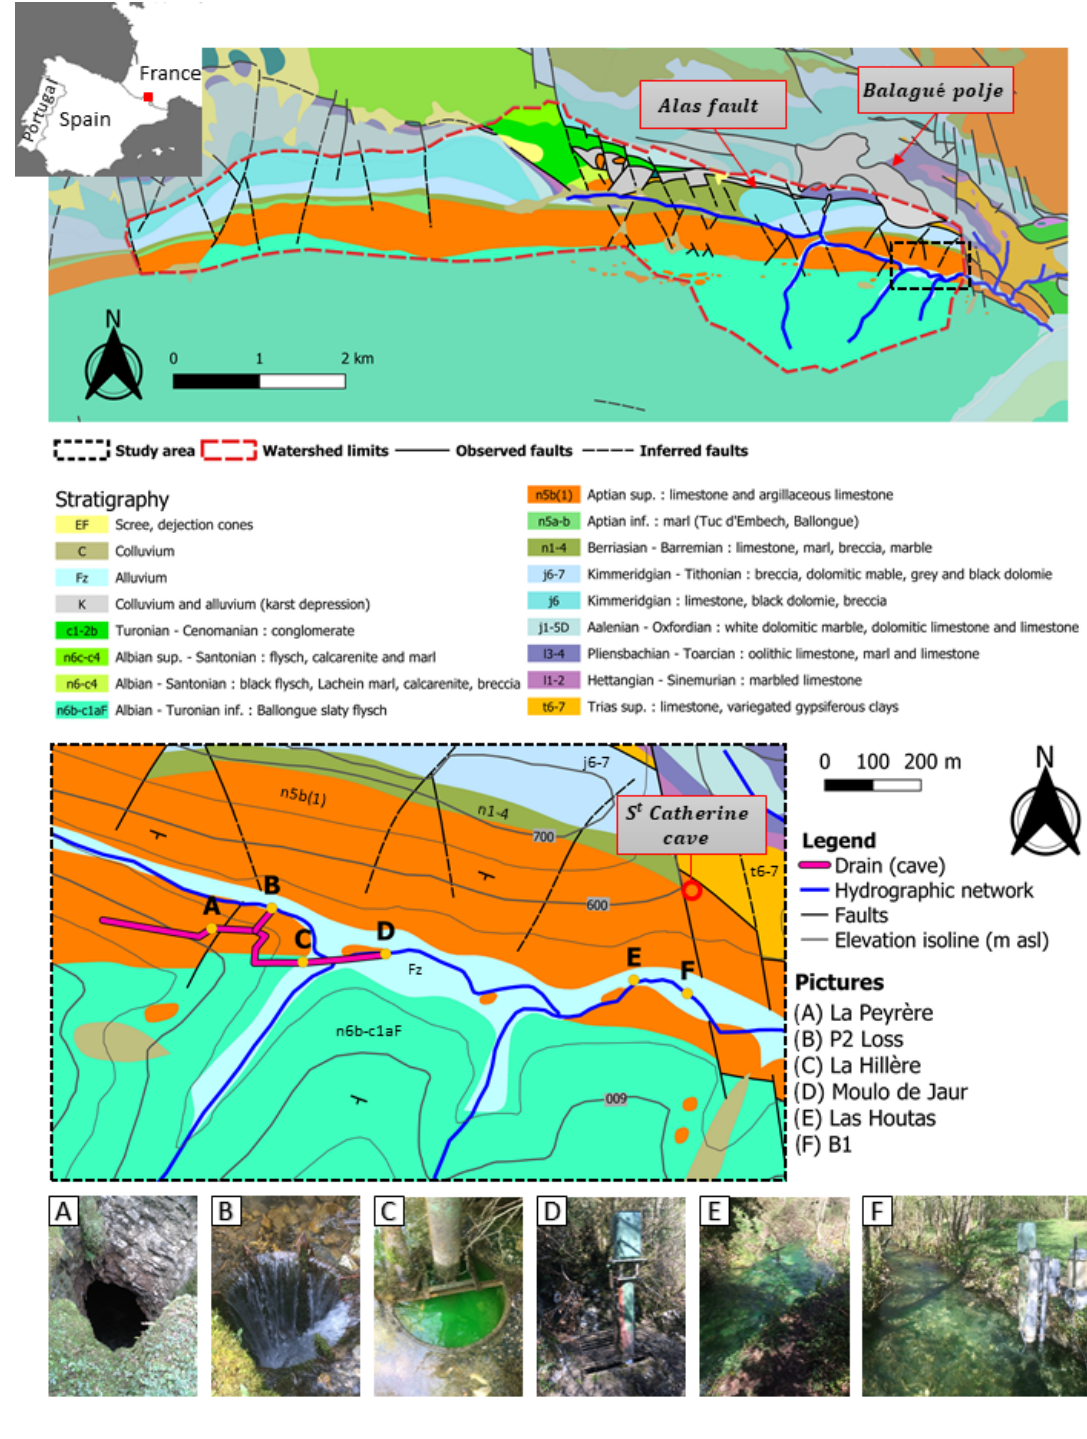
Figure 1. Location of the Baget karstic system, a geological map of the area (modified from [54]) and limits of the watershed (red dashed line). The study area concerns the downstream part of the watershed (black dashed line), in the mid mountains Lachein valley, characterized by altitude from 450 m a.s.l. to 750 m a.s.l. [55]. The pictures show remarkable features across the area: ( A ) La Peyrère is a cave connected to the main drainage system, ( B ) P2 Loss is the point of injection for artificial tracer tests, ( C ) La Hillère is a temporary resurgence, ( D ) Moulo de Jaur is a temporary resurgence and an intermediate observation point of tracer transport, ( E ) Las Hountas is the perennial spring of the watershed and the tracer recovery point and ( F ) B1 is the gauging station (discharge, water sampling, and fluorimeter), modified from [13].